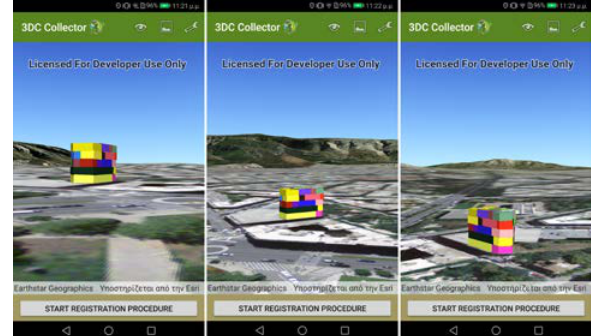
Figure 8. 3D models of the declared properties, using the 3D Model tool of the developed mobile application